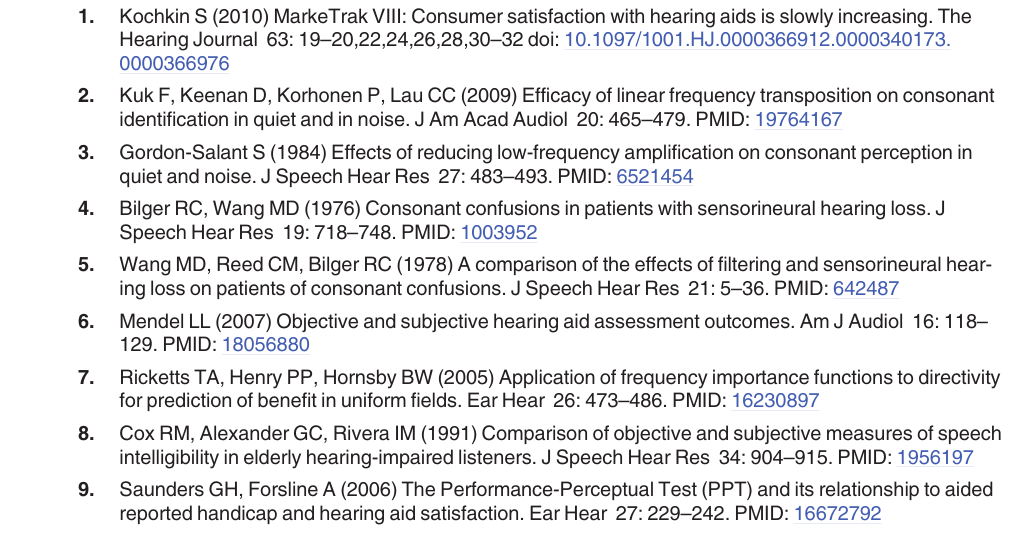
S9 Table. Correlations of pure-tone audiometric thresholds (averaged over ears) with HA benefit on consonant group thresholds and on